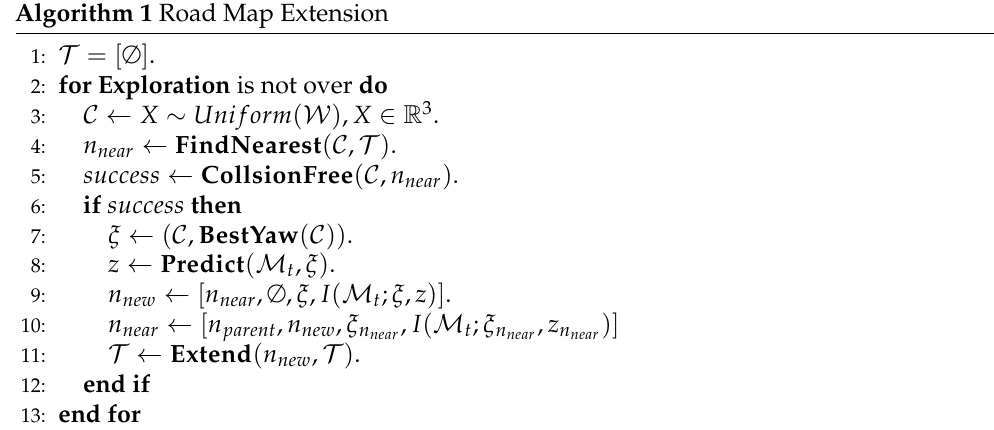
Algorithm 1 Road Map